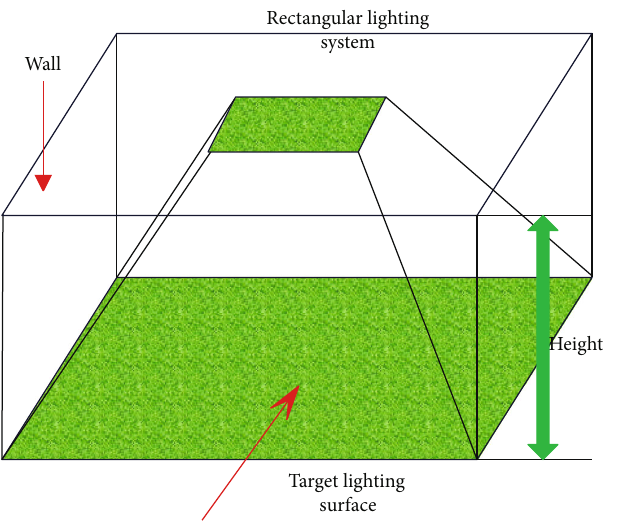
Figure 1: Schematic diagram of rectangular lighting based on cutting visual communication images.